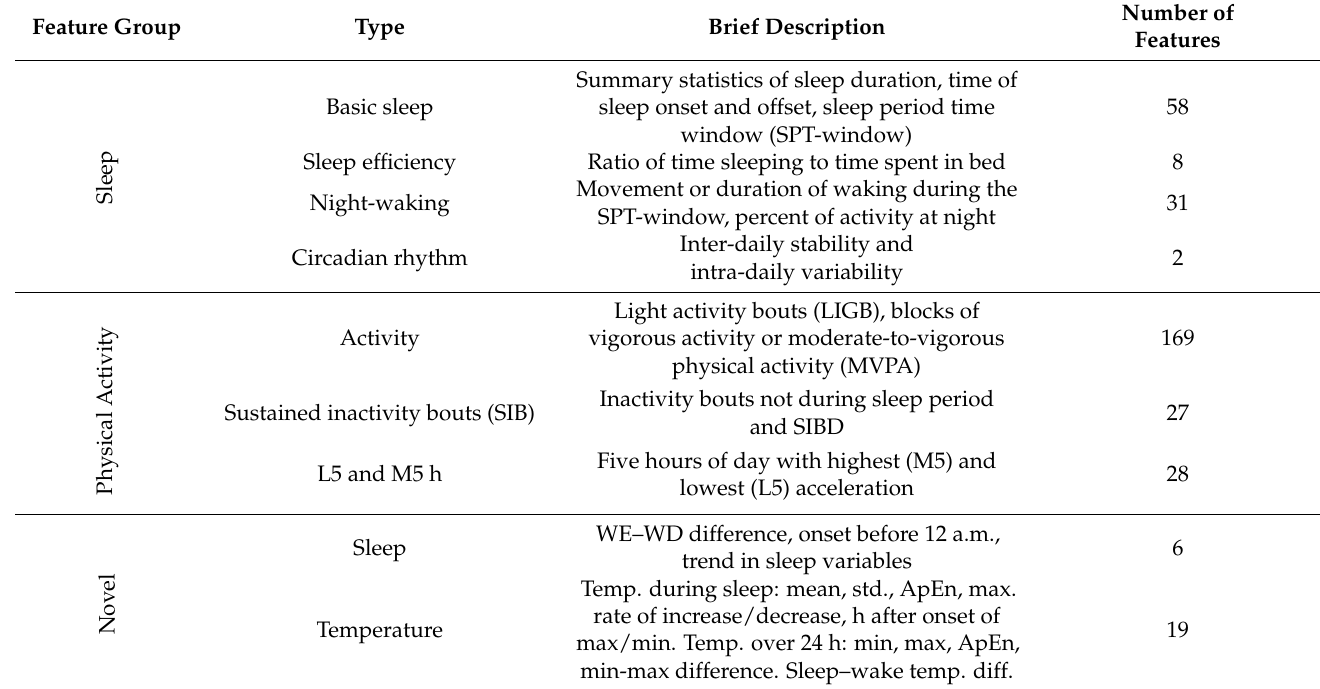
Table 1. Summary of feature groups used in this study. Total movement and duration of movement during the SPT-window and percent of activity at night were computed using GGIR-extracted features, rather than extracted directly. We computed 323 features using known methods and propose 25 novel features to characterize sleep and temperature in this study.